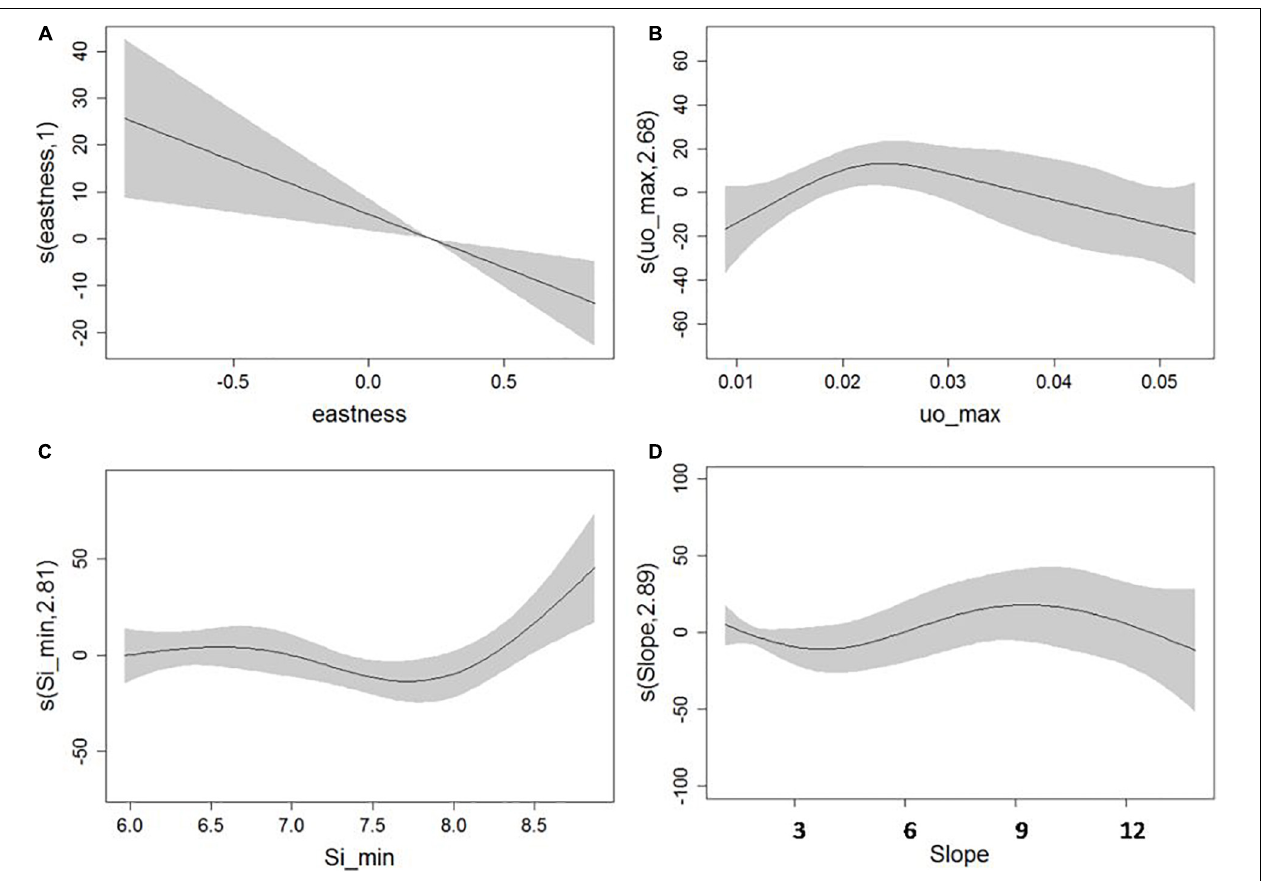
FIGURE 6 | Generalized additive models response curves for eastness (A) , bottom current u component (B) , minimum value of silicates during 1 year (C) , and slope (D)